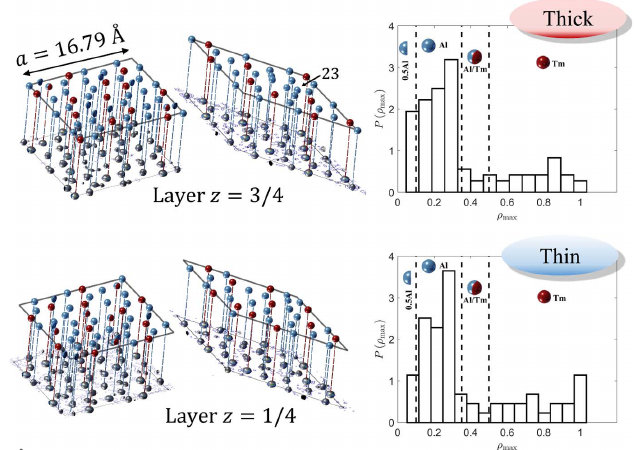
Figure 6 Initial atomic decoration of two rhombi of the RPTat each atomic layer. Color coding is as follows: red – TM, blue – Al, blue/red – mixed atom, blue half-sphere – partially occupied site by Al. Atom 23 (see the supporting information for details) is indicated. The atom potentially causes the point density of the model to be too high. The distributions of electron density ( (cid:10) max ) in the positions of local maxima are plotted for thick (top) and thin (bottom) rhombi. The electron density is normalized by the maximal electron density within each rhombus. Two emerging sectors correspond to two atomic species likely to be present in the